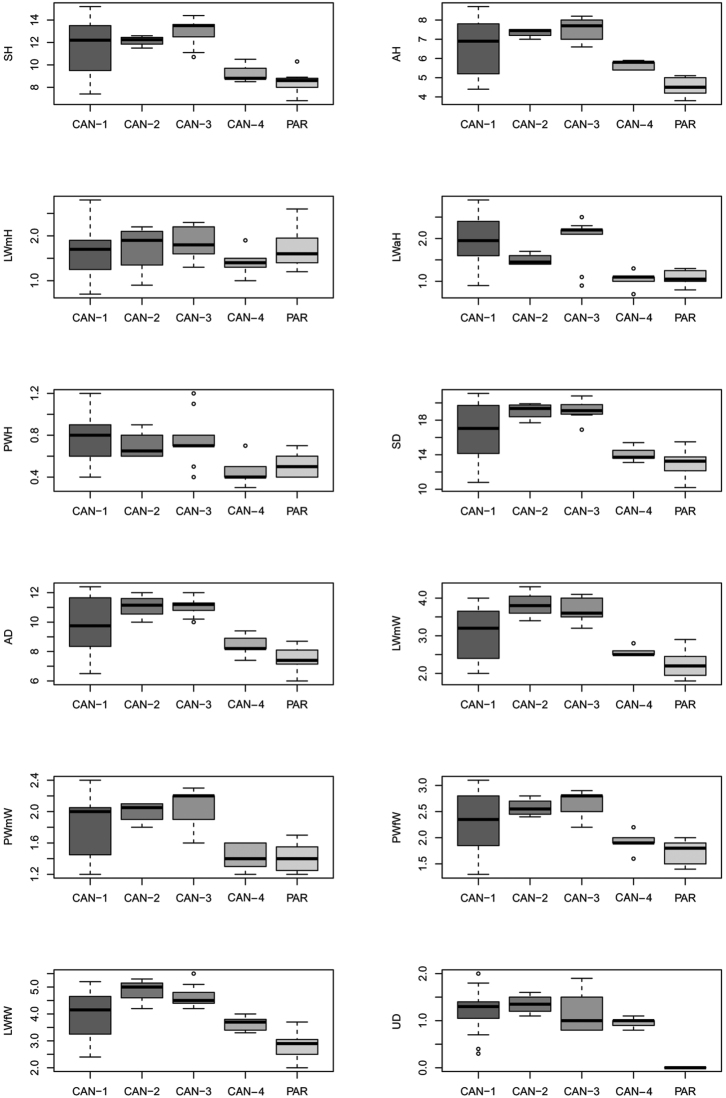
Box plots for shell characters of the five Monacha clades investigated. The lower and upper limits of the rectangular boxes indicate the 25th to 75th percentile range, and the horizontal line within the boxes is the median (50th percentile).